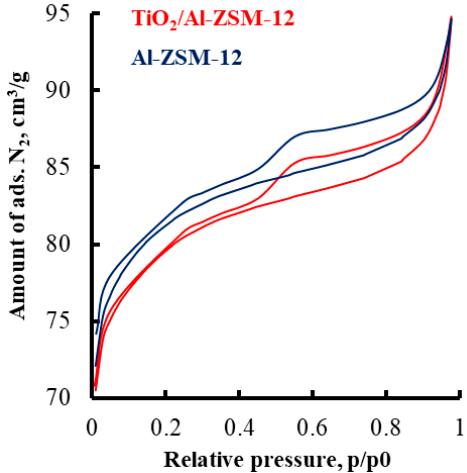
Figure 2. N 2 adsorption–desorption isotherms of synthesized zeolites. Table 1. Composition and textural characteristics of synthesized zeolites.